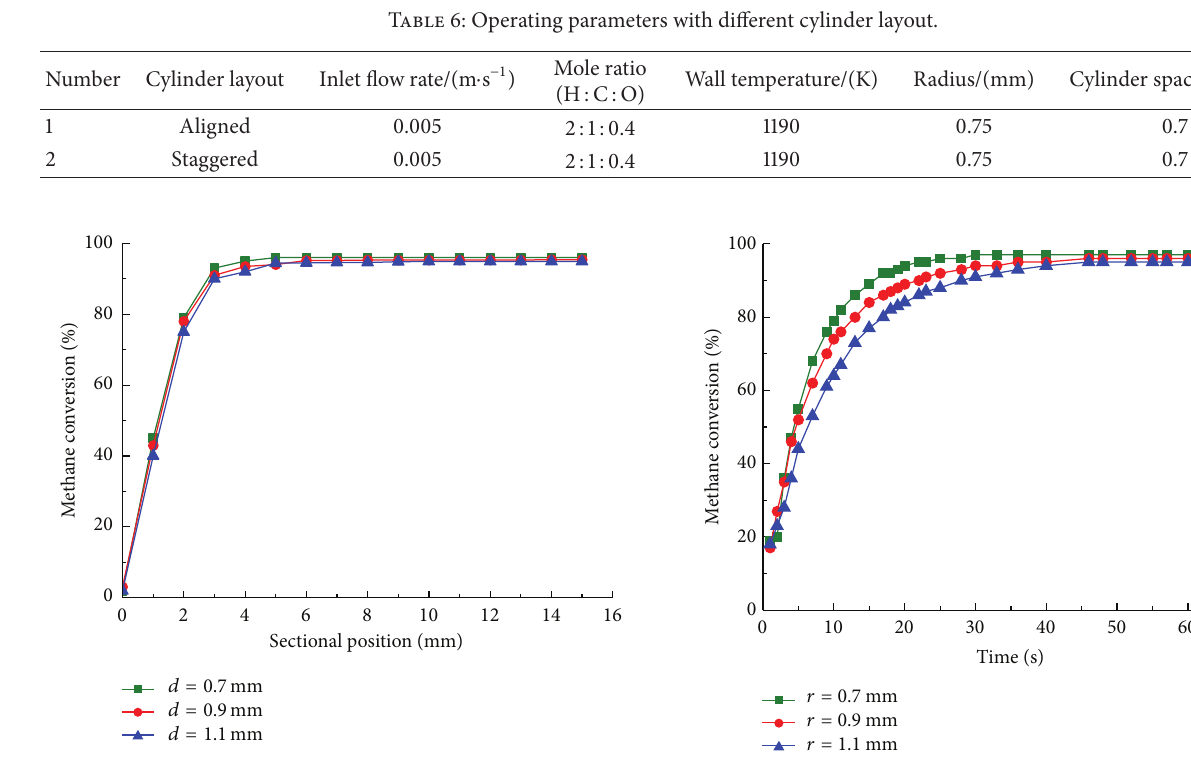
Figure 8: Methane conversion with cylinder spacing of 0.7mm ( ◼ ), 0.9 mm ( e ), and 1.1mm ( 󳵳 ) for different reaction